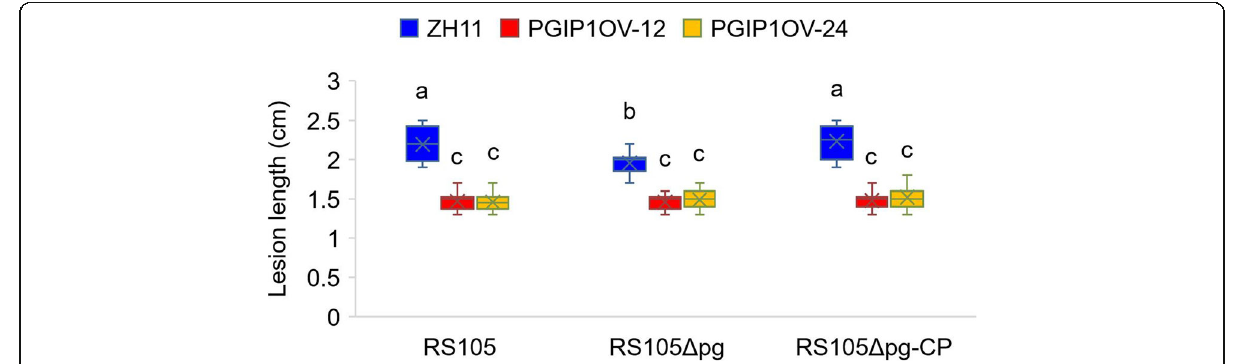
Fig. 4 OsPGIP1 -mediated resistance is complemented and induced by XocPG in addition to other Xoc pathogenicity factors. Lesion lengths of RS105, RS105 Δ pg and RS105 Δ pg-CP in ZH11 and OsPGIP1 -overexpressing lines OV-12 and OV-24. The letters above the bars represent the significant differences at a value of P ≤ 0.05 (LSD test). The above experiment was repeated three times with similar